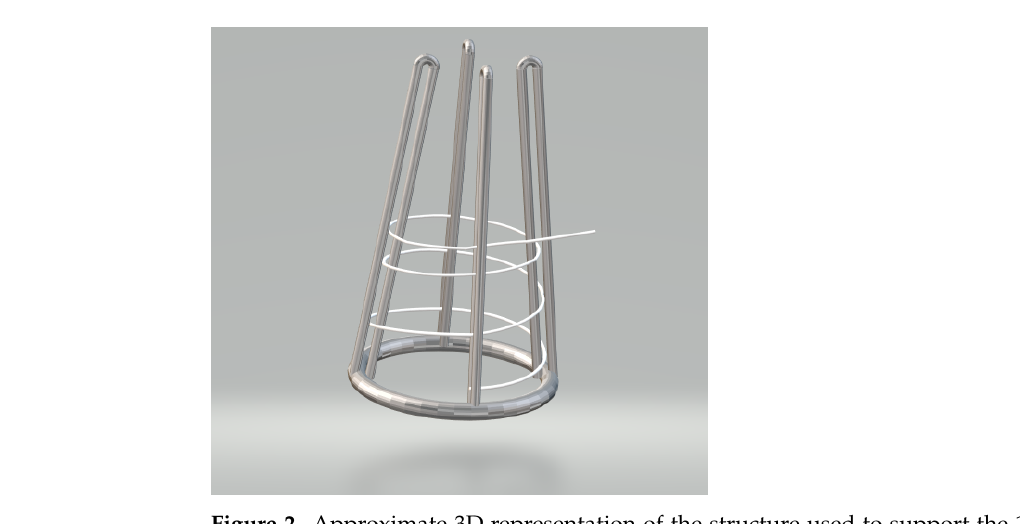
Figure 2. Approximate 3D representation of the structure used to support the 150 cm long PLA filament during its SCI.